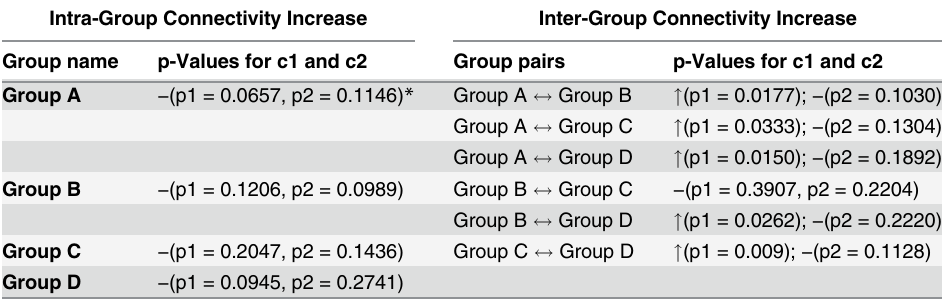
Table 3. The difference in the intra- and inter-group connectivity among sub-networks in the upper alpha band between the WE-IL and the WE-IT conditions. Intra-Group Connectivity Increase